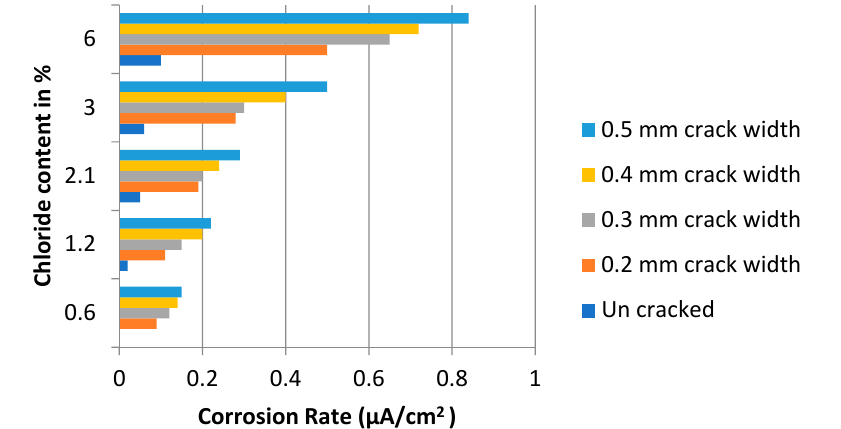
Figure 5. Average chloride concentration in concrete influenced by crack quantity [31,51,52].